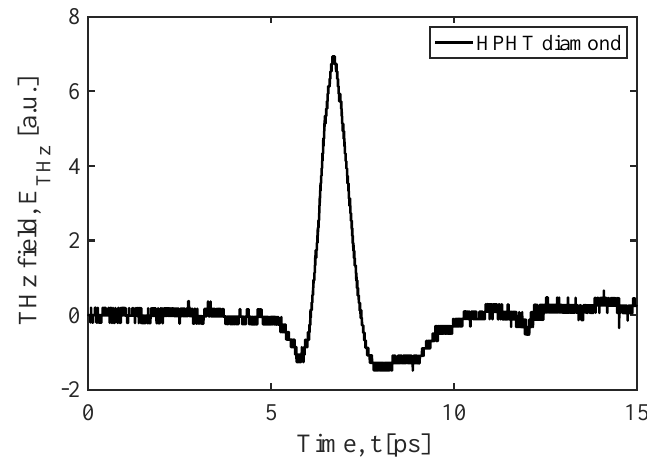
Figure 5. Waveform of THz pulse produced by HPHT diamond